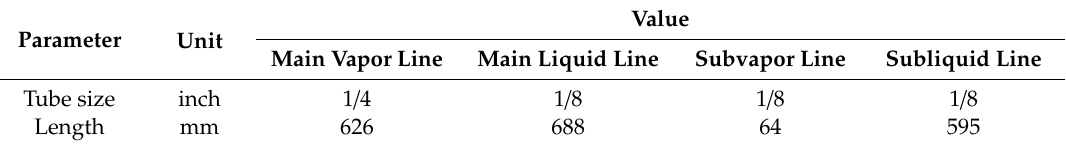
Table 5. Condition for calculating the pressure drop in the vapor / liquid